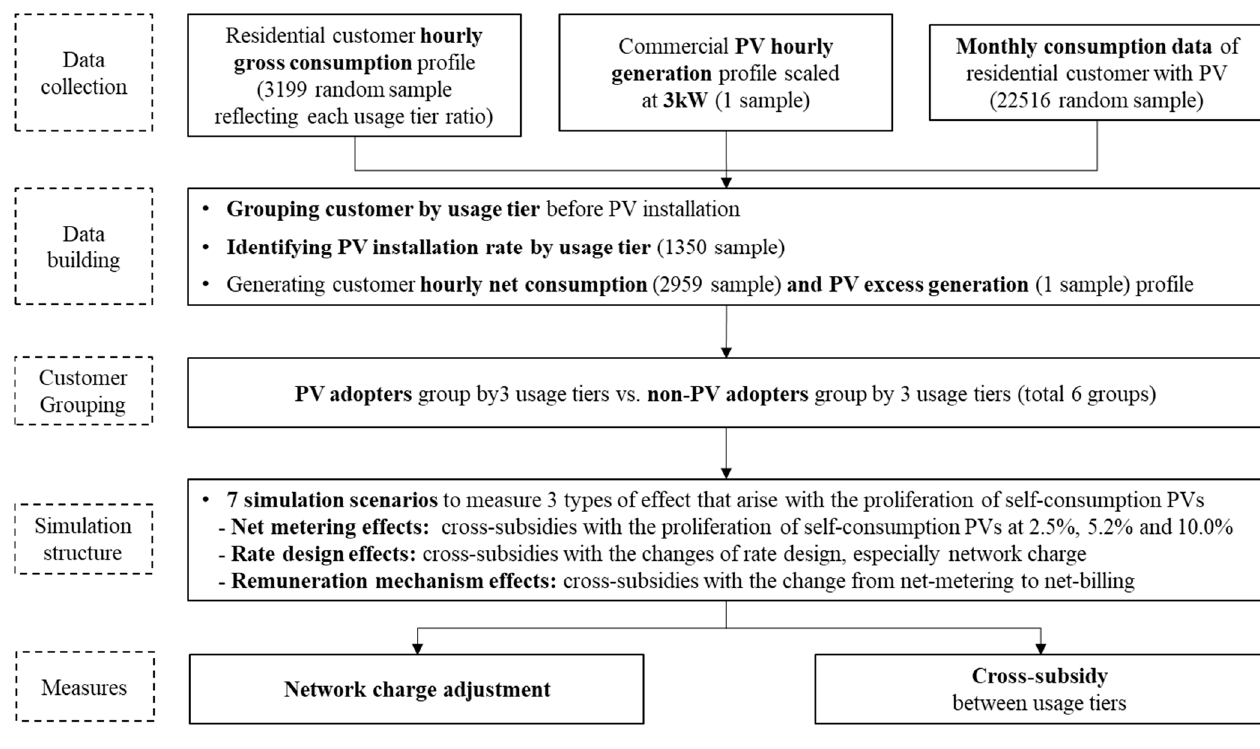
Figure 1. Summary of analysis structure. Table 3. Simulation